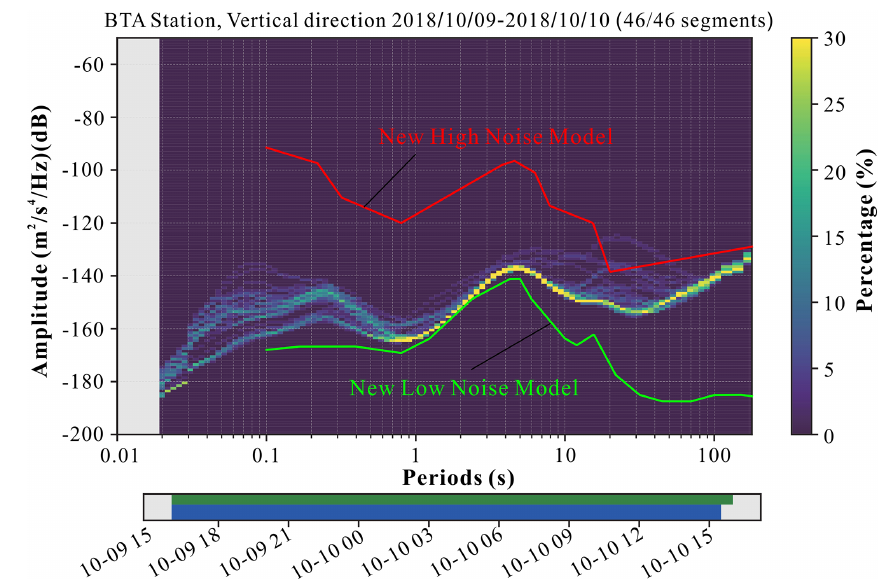
Figure 3. Probabilistic power spectral density of the vertical component at seismic station BTA. Red line in the PSD image is NHNM and green line is NLNM. Below the PSD image is a visualization of the data basis for the calculation. The top row shows data fed into the calculation, with green patches representing available data. The bottom row in blue shows the single PSD measurements that go into the